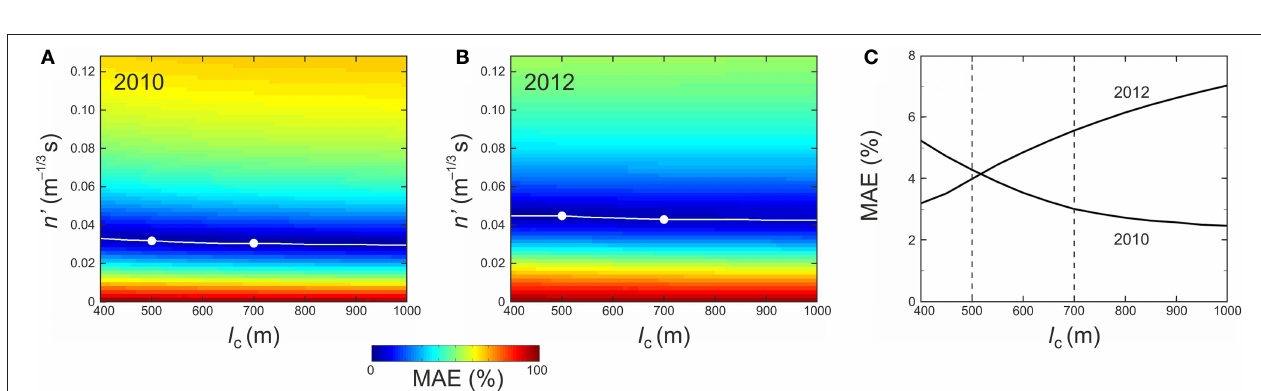
FIGURE 4 | (A,B) Mean absolute error (MAE) of the misfit between simulated and observed hydrographs for 2010 and 2012 for different values of Manning roughness n’ and conduit length l c , plotted in color over their parameter space. White lines locate minimum MAE for each l c . Dots locate the model runs in Figure 5 for l c 700m and l c 500m. (C) Minimum MAE as a function of l c for the two outbursts. =